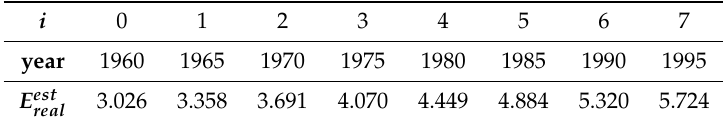
Table 1. Estimation interval T est .